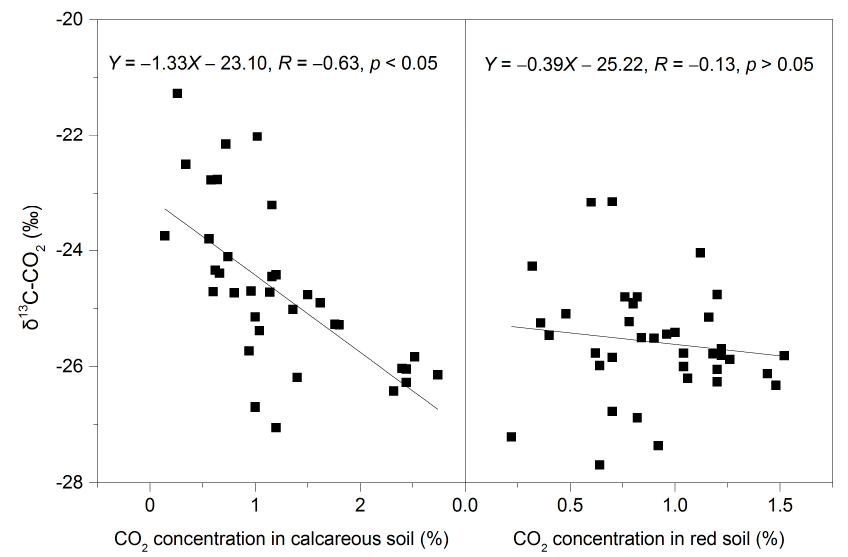
Figure 8. Association between δ 13 C-CO 2 and the CO 2 concentration in calcareous and red soils.